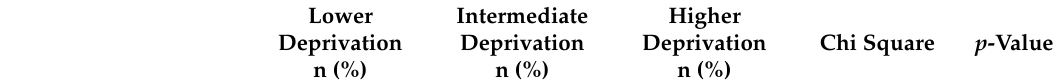
Table 2. Association between sociodemographic and clinical characteristics and social deprivation (Chi Square analysis).